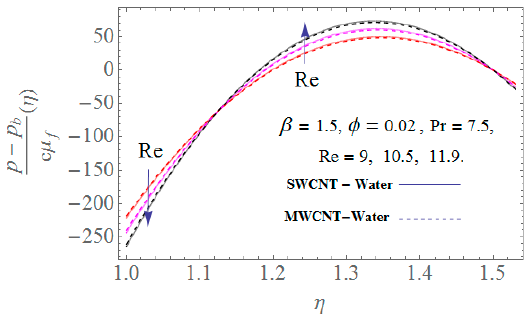
Figure 9. The impact of the thin film thickness parameter versus temperature field.